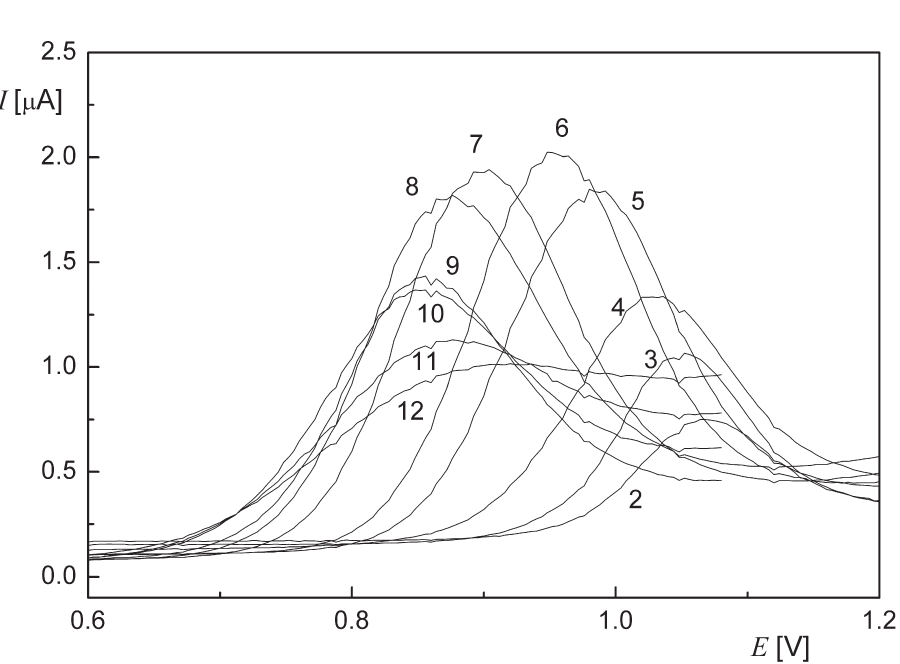
Figure 1. DP voltammograms of metoclopramide (100 µmol L -1 ) at BDDFE in various BR buffers (pH value noted above the curve).